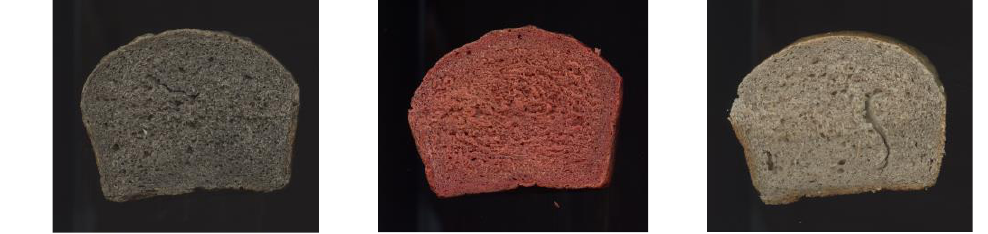
Figure 3 Rye – wheat breads, from left to right: control sample, bread with BH, BR and FL . Figure 3. Rye–wheat breads, from left to right: control sample, bread with BH, BR and